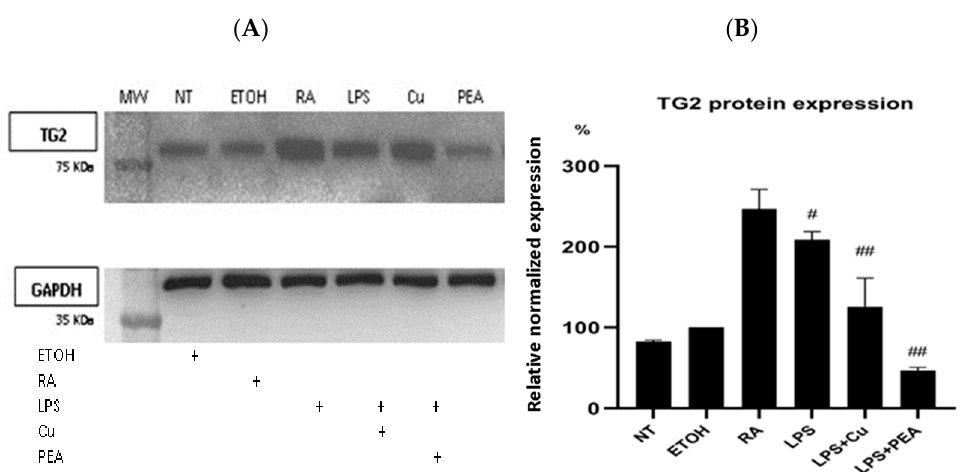
Figure 3. Panel ( A ): Western blot for TG2 protein expression. BV2 cells were cultured in medium supplemented or not (NT) with 10 µ M of PEA and Cu or in presence of 1 µ g/mL LPS for 48 h. Cells were treated also with 10 µ L of ethanol (ETOH) as a negative control or with 10 µ M retinoic acid (RA) as a positive control. SDS-PAGE was blotted with an antibody against TG2. GAPDH protein expression was used as loading control. The experiments were performed at least 3 different times and the results were always similar; Panel ( B ): graph shows the densitometric intensity of TG2/GAPDH bands ratio. # p value < 0.05 compared with control group (NT). ## p < 0.05 compared with LPS